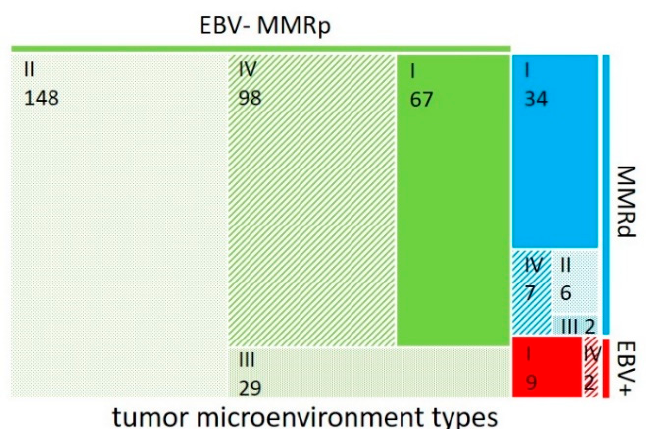
Figure 4. Distribution of tumor microenvironment types based on PD-L1 status and the number of intratumoral CD8+ lymphocytes across EBV+, MMRd, and EBV-MMRpGCs. An area proportional tree map illustrates the frequency of the different tumor microenvironment types depending on the EBV and MMR status of the tumors. Tumor microenvironment types are based on the PD-L1 and CD8 int status: type I (adaptive immune resistance; PD-L1+/CD8 int high), type II (immunological ignorance; PD-L1-/CD8 int low), type III (intrinsic induction; PD-L1+/CD8 int low), and type IV (tolerance; PD-L1-/CD8 int high).